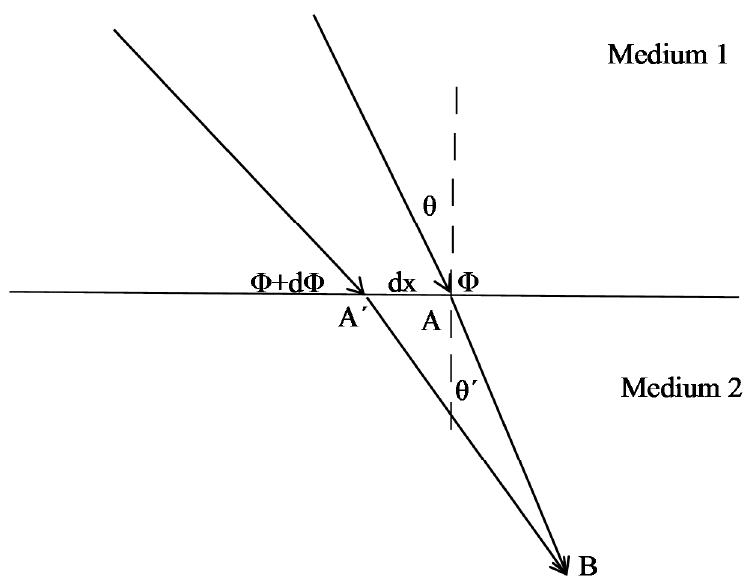
Figure 1. An illustration of generalised law of refraction. Φ and Φ + d Φ are phase discontinuities at A (cid:48)